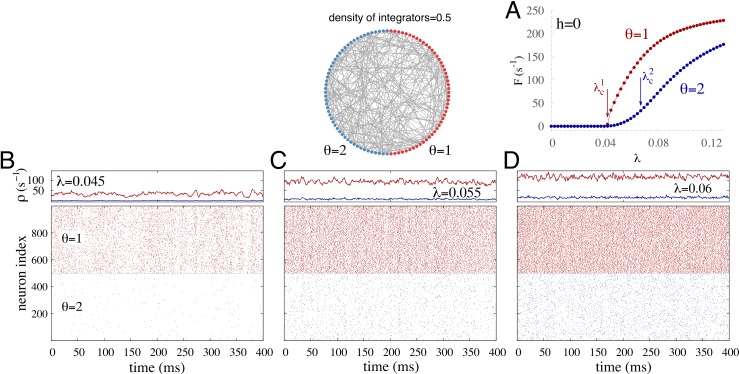
Illustrative dynamics in the simplest case of diversity in the excitability threshold θ.Bimodal distribution with equal numbers of integrators (θ = 2) and non-integrators (θ = 1). (A) Spontaneous activity F(h = 0) ≡ F0 versus coupling strength λ. The critical coupling for the subpopulation θ = 1 and θ = 2 is respectively \documentclass[12pt]{minimal}
\usepackage{amsmath}
\usepackage{wasysym}
\usepackage{amsfonts}
\usepackage{amssymb}
\usepackage{amsbsy}
\usepackage{upgreek}
\usepackage{mathrsfs}
\setlength{\oddsidemargin}{-69pt}
\begin{document}
}{}${\lambda }_{c}^{1}=0.0425$\end{document}λc1=0.0425 and \documentclass[12pt]{minimal}
\usepackage{amsmath}
\usepackage{wasysym}
\usepackage{amsfonts}
\usepackage{amssymb}
\usepackage{amsbsy}
\usepackage{upgreek}
\usepackage{mathrsfs}
\setlength{\oddsidemargin}{-69pt}
\begin{document}
}{}${\lambda }_{c}^{2}=0.0675$\end{document}λc2=0.0675. (B–D) Time traces and raster plots for different coupling strength λ. Top panels: instantaneous firing rate ρ averaged over nodes from each subpopulation (θ = 1 is in red, θ = 2 is in blue). Bottom panels: raster plot of 500 randomly chosen units from the integrator (blue) and nonintegrator (red) subpopulations. The external driving is h = 10−2 Hz.